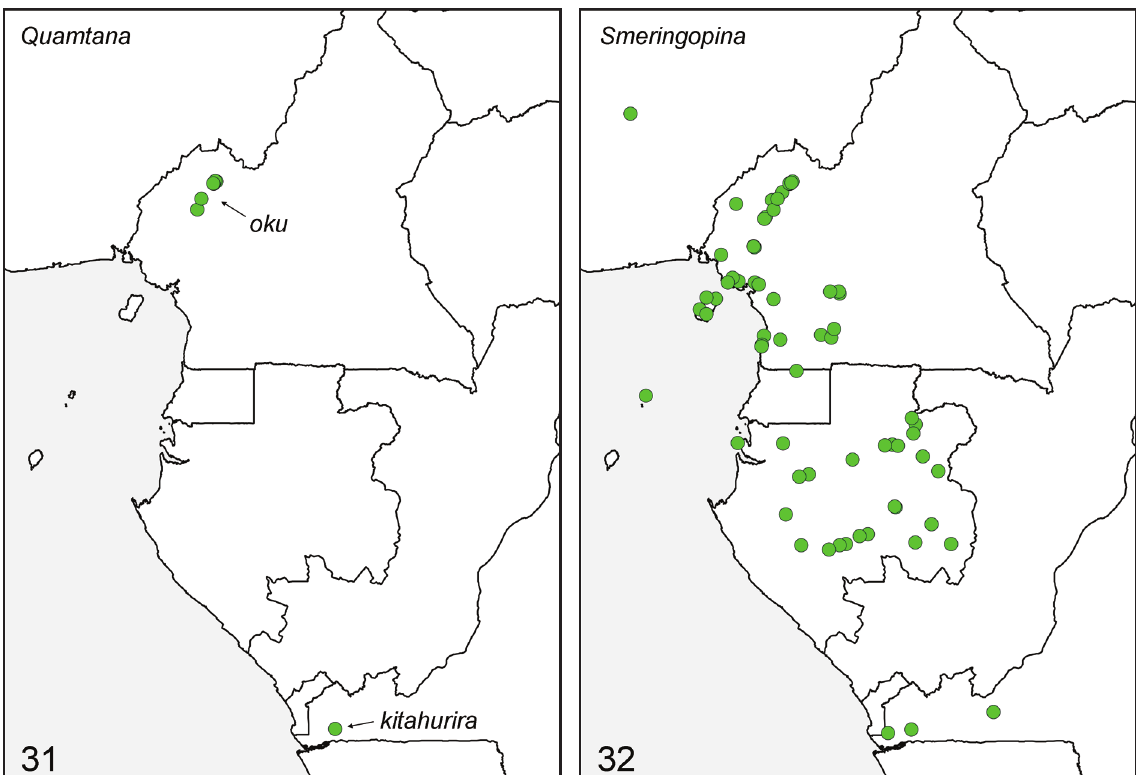
Figs 31-32. Known distributions of the genera Quamtana Huber, 2003 and Smeringopina Kraus, 1957 in Central Africa. For detailed distribution maps of Smeringopina species see Huber